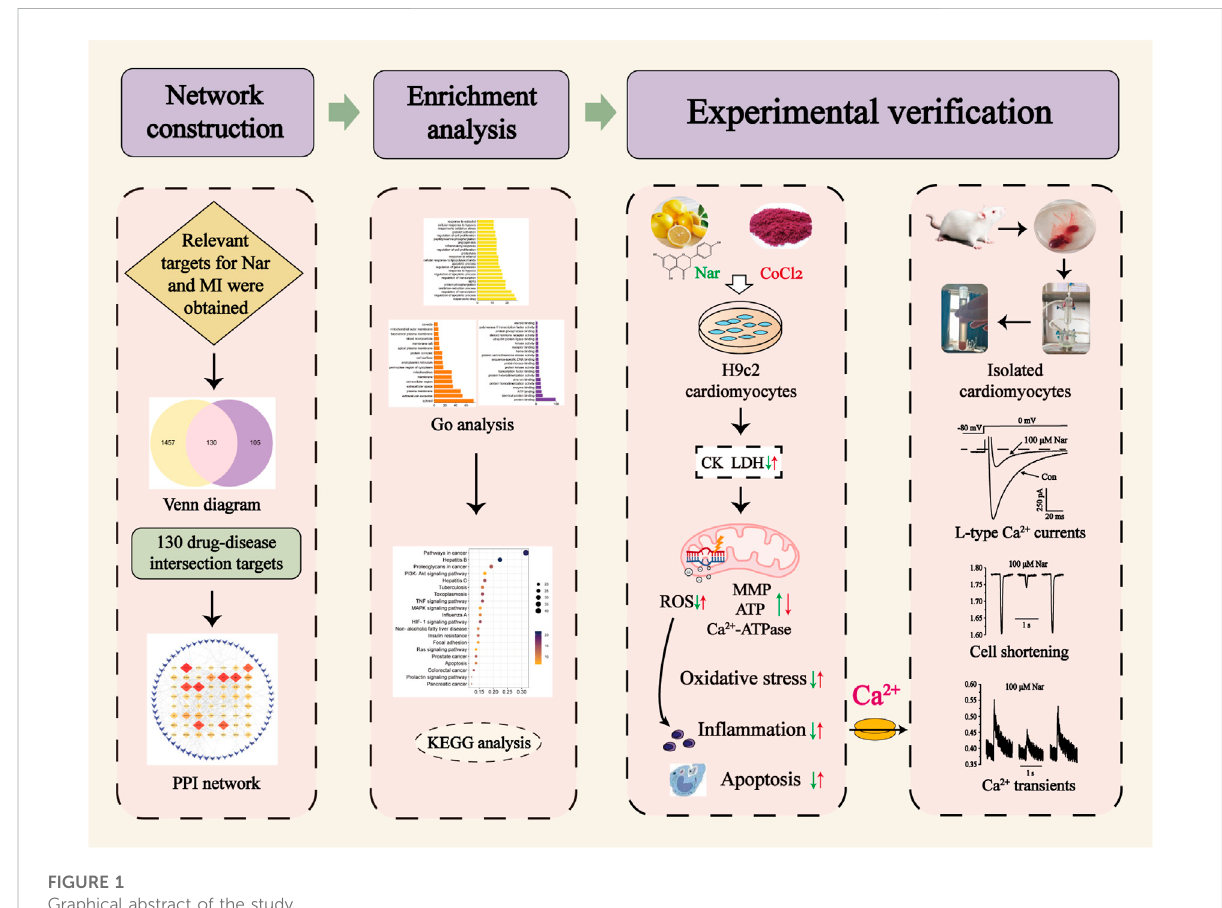
FIGURE 1 Graphical abstract of the